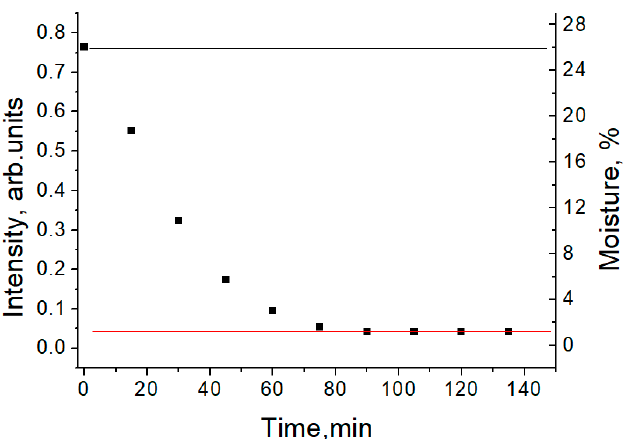
Figure 11. Comparison of the peak intensities of the diffuse band of water in kaolinite with the moistures of the sample measured by the drying method. The black and red horizontal lines mark, respectively, the moisture at the beginning of the experiment (26%), and in the naturally dry state (1–2%).